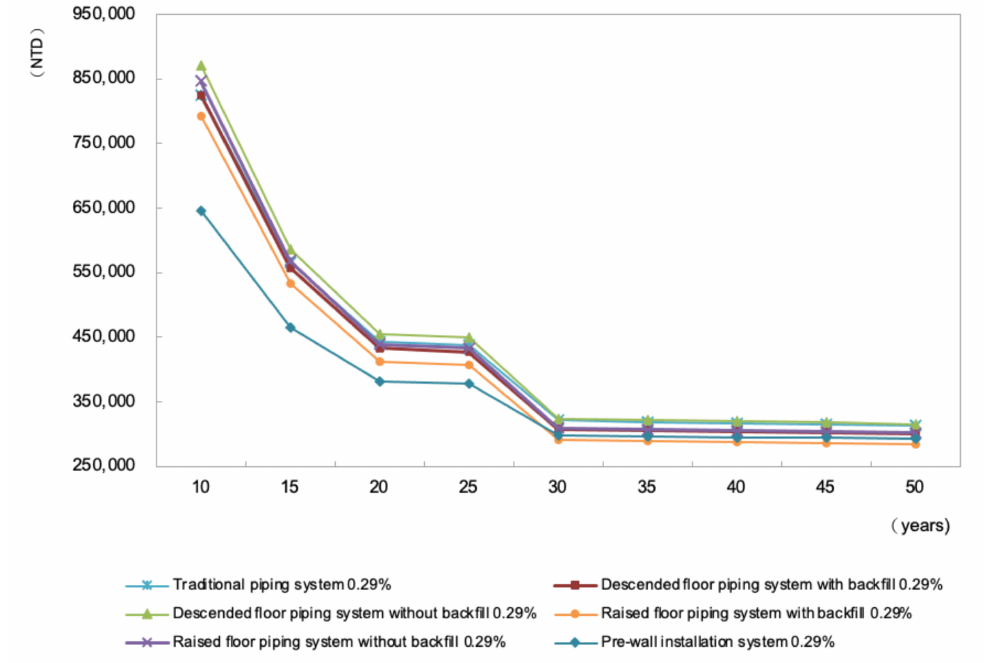
Figure 9. Life cycle costs for the complete replacement of pipelines in the four types of bathroom piping systems after changing the traditional piping system to the raised floor piping system with backfill, with discount rate of